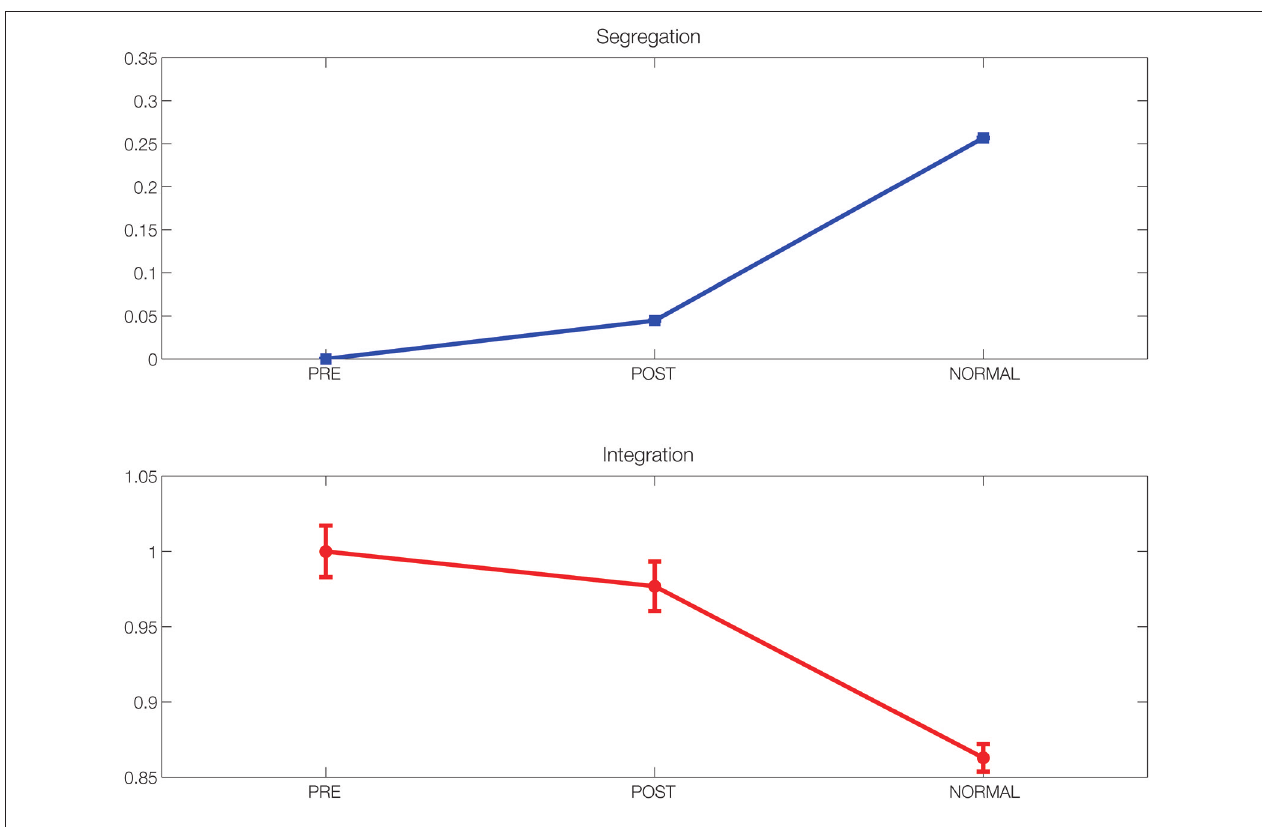
obtained using the connectivity from the healthy population (FC_normal). Both measures improved after 5 months of DBS, although not to the level found in the normal